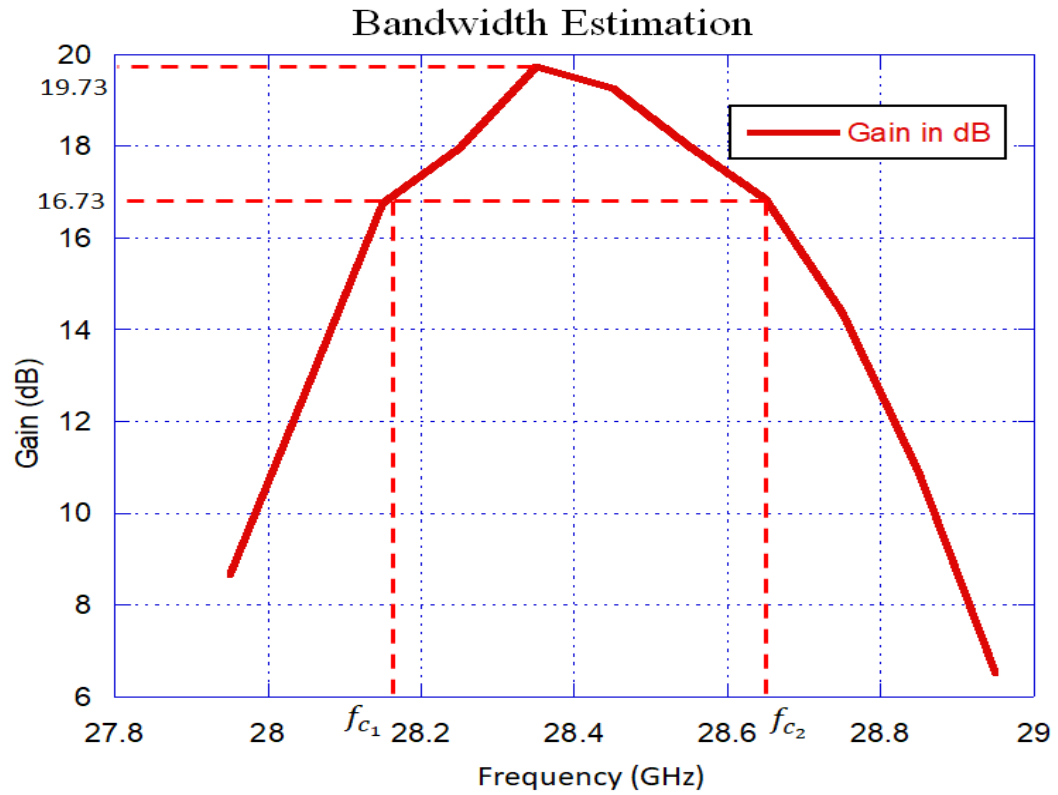
Figure 18. Graphical representation of gain vs.